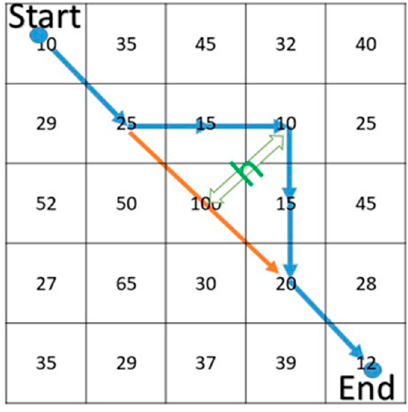
Figure 13. The line based cartographic simplification effect on the suggested route.